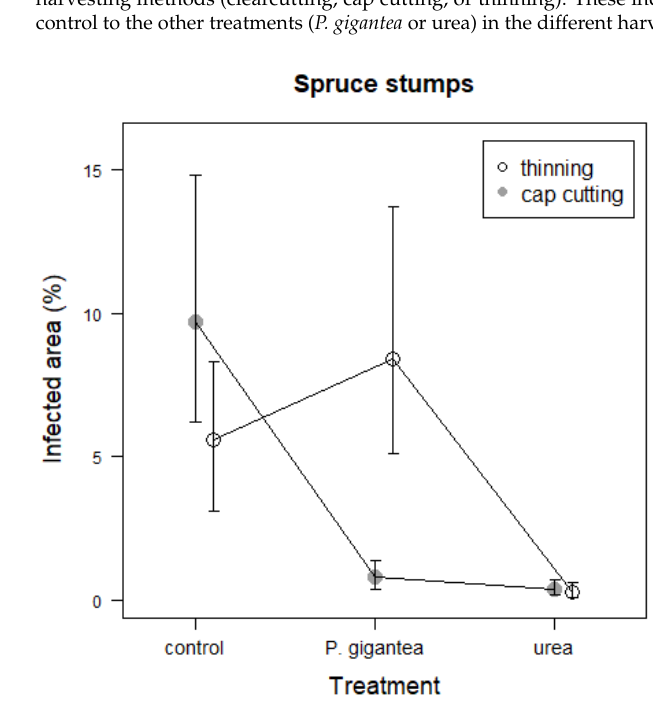
Figure 1. Area covered by Heterobasidion sp. (%) in the control, P. gigantea , and urea treatments in Norway spruce stumps in thinning and cap cutting. Predicted values with standard errors of means (SE) in different treatments and harvesting methods based on the estimated model are presented.